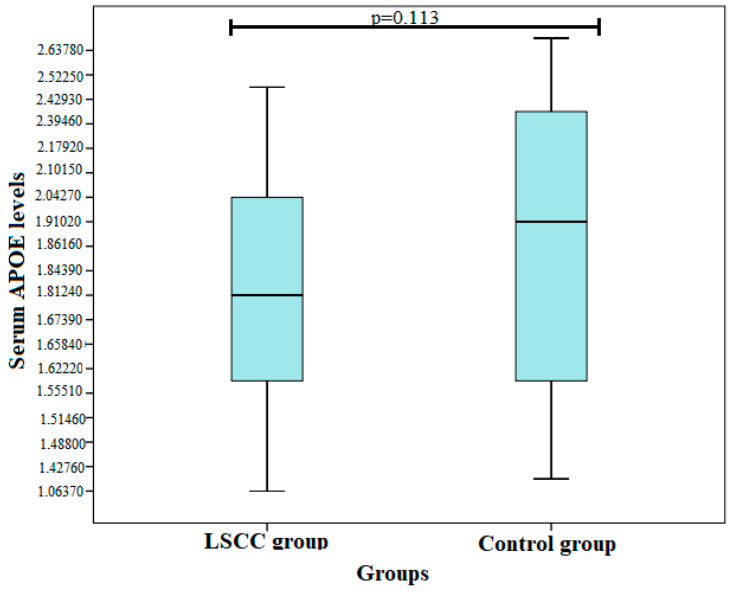
Figure 1. Serum ApoE levels in LSCC and control